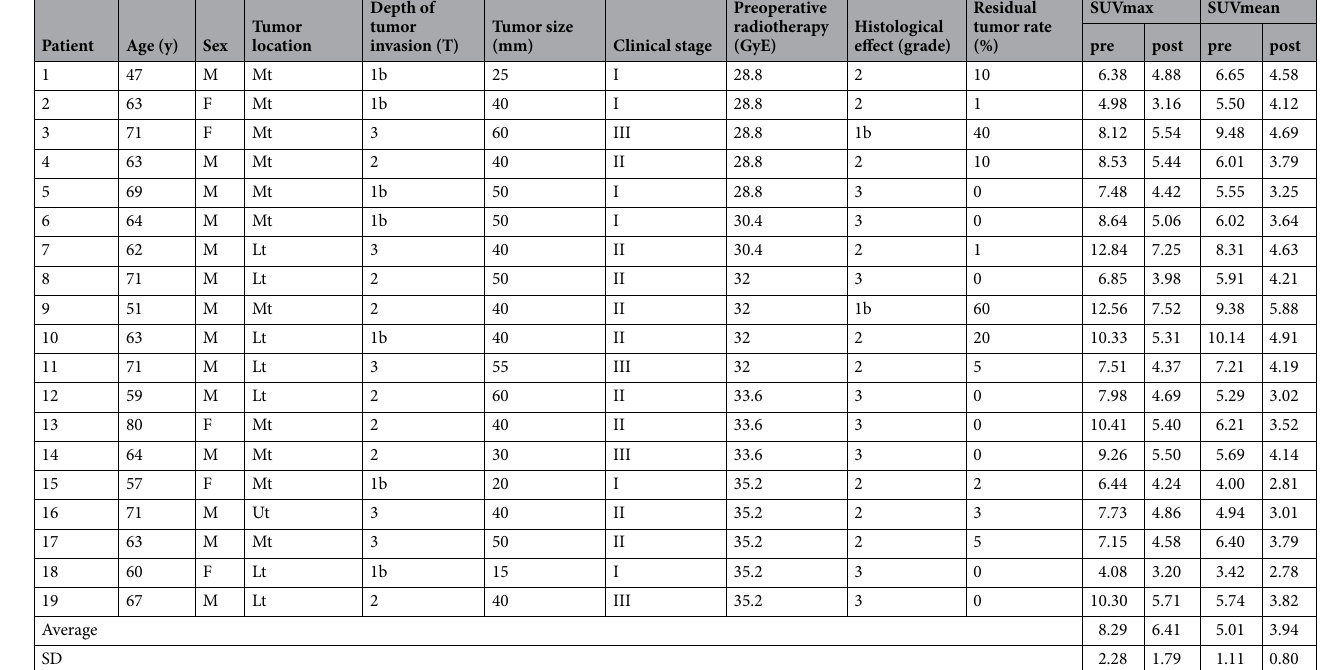
Table 1. Summary of patient profiles and MET PET/CT findings in patients with neoadjuvant CIRT for esophageal cancer. Ut , upper thoracic esophagus; Mt , middle thoracic esophagus; Lt , lower thoracic